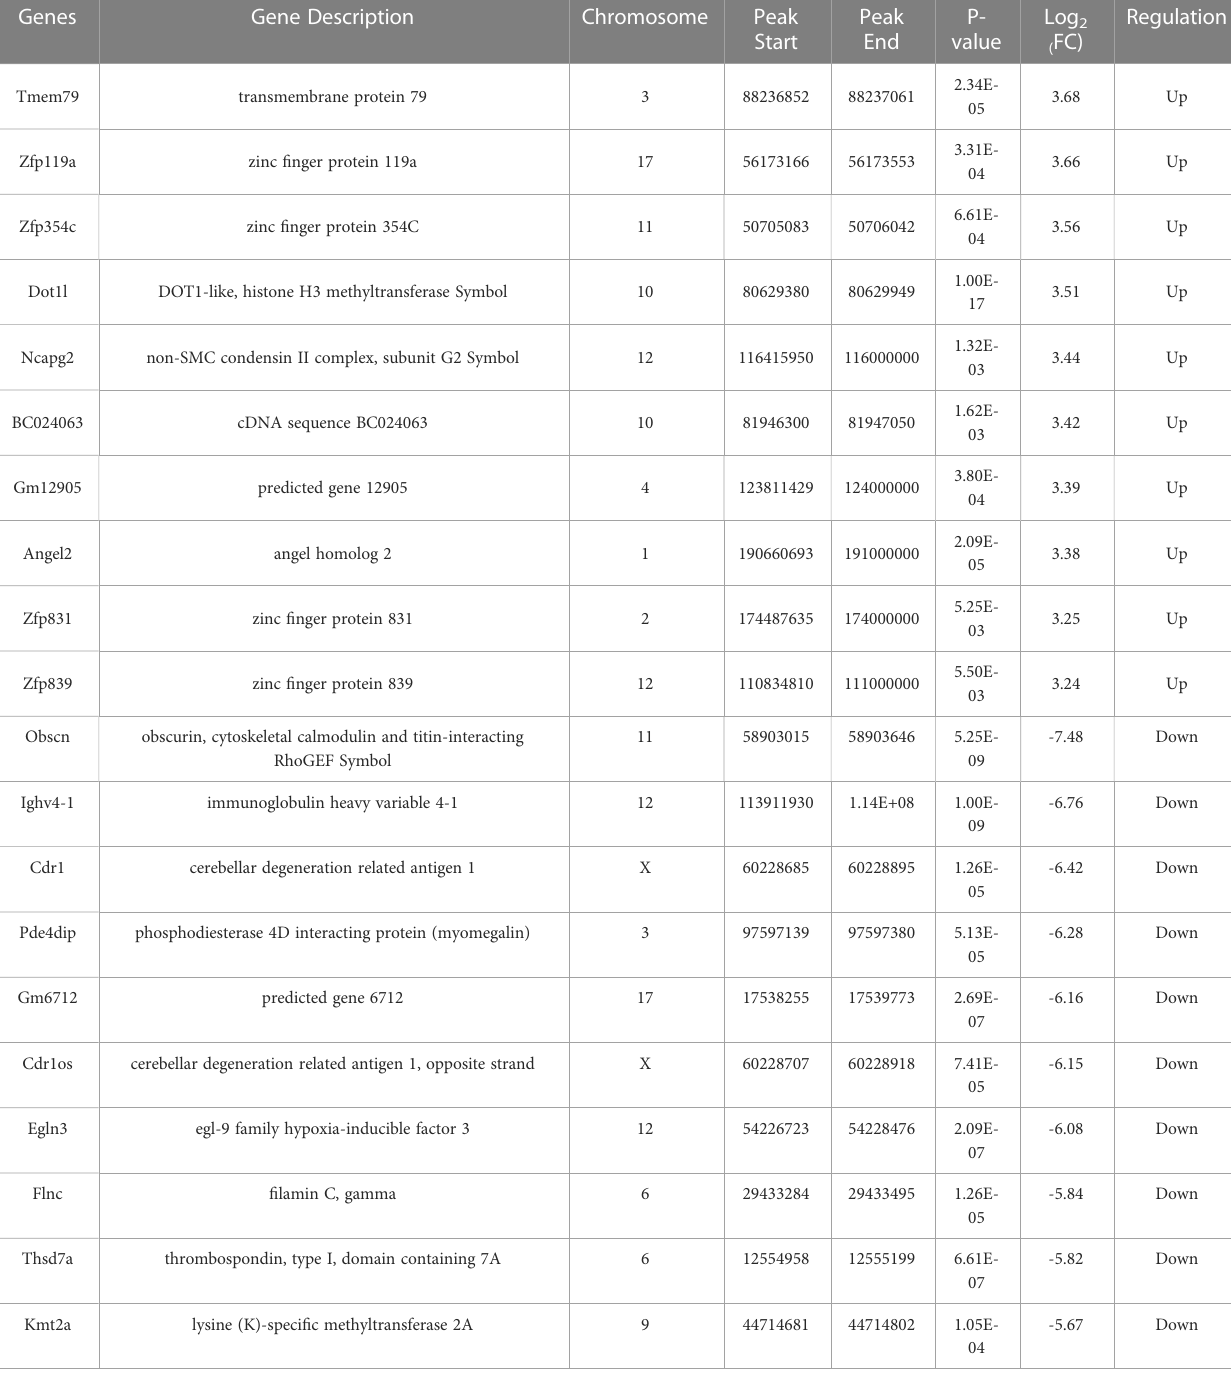
TABLE 3 Top 10 differentially expressed mRNAs between AECOPD and control group based on log 2 (FC) value.